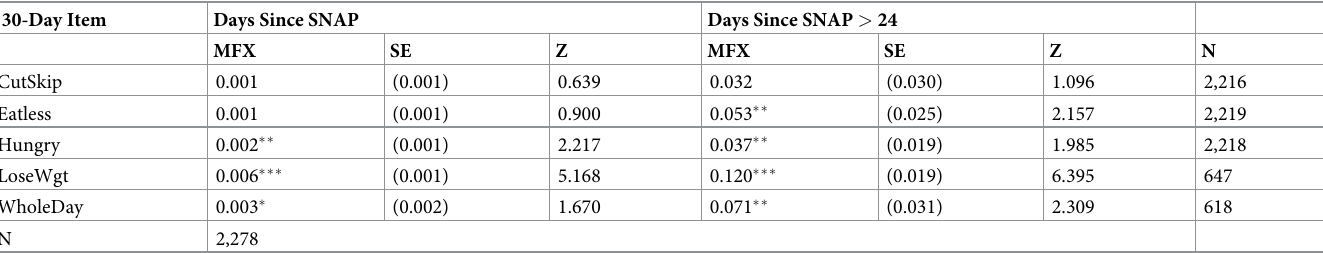
Table 4. Marginal effects of days since SNAP on 30-day food security items.